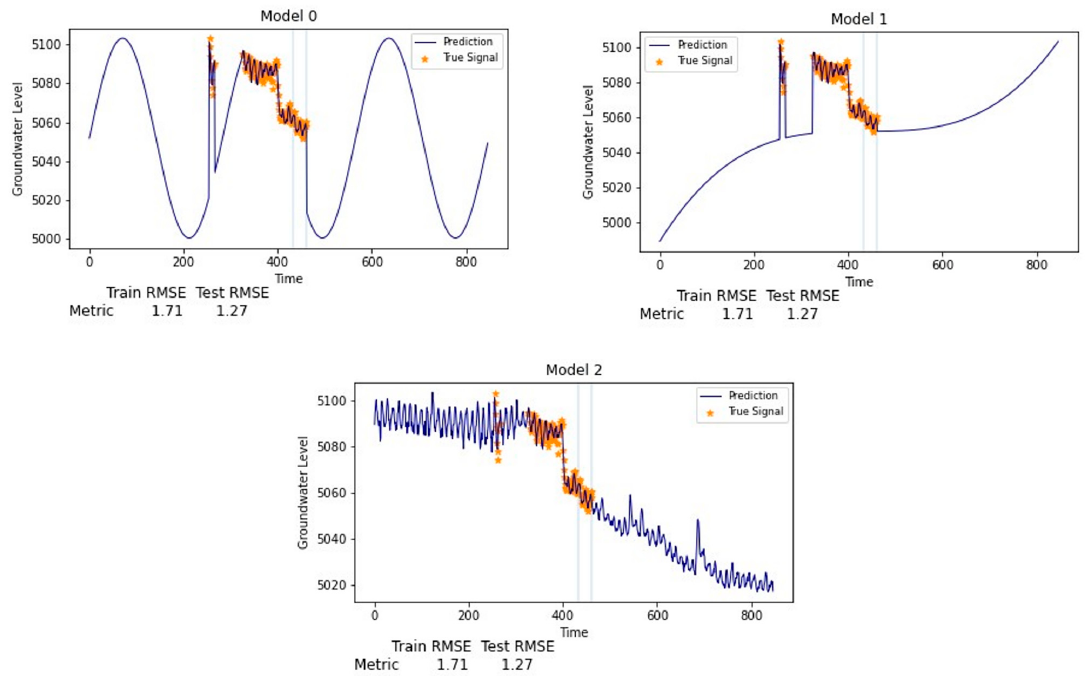
Figure 4. Three generated models depicting how different data structures can produce very similar training and testing results yet generalize very differently.